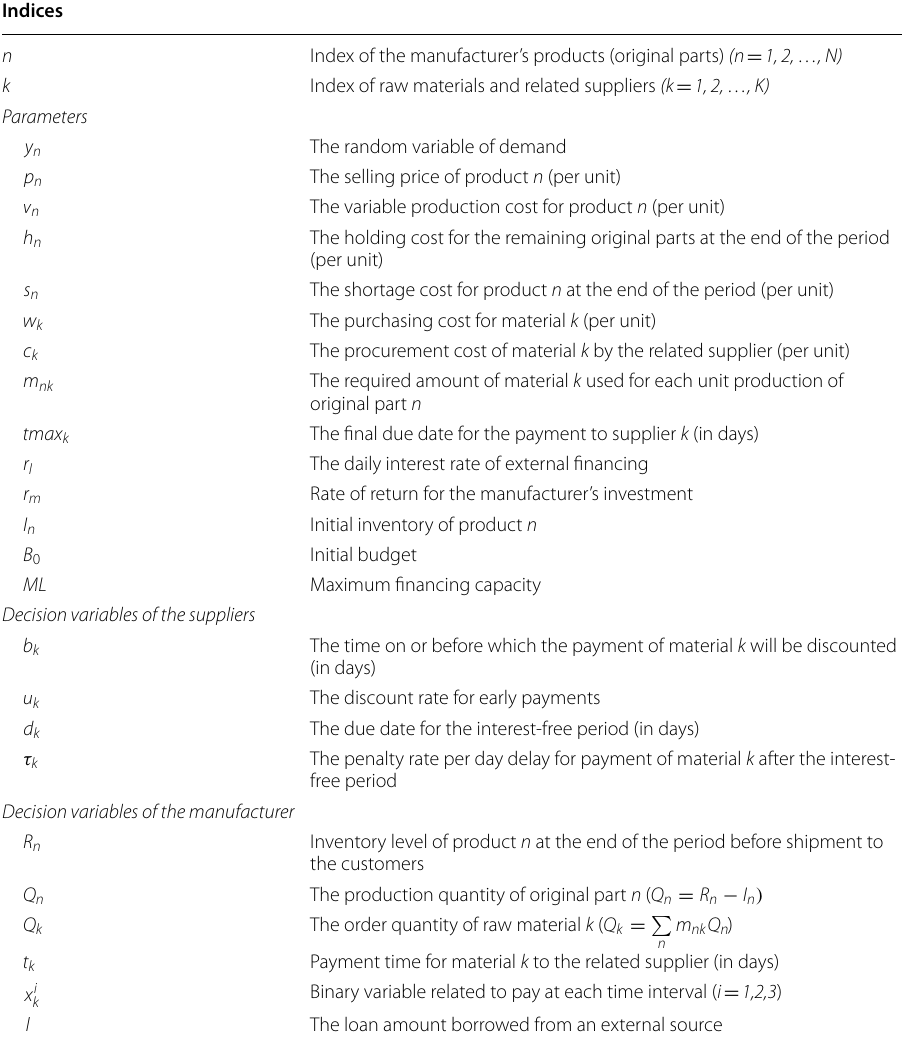
Table 2 list of